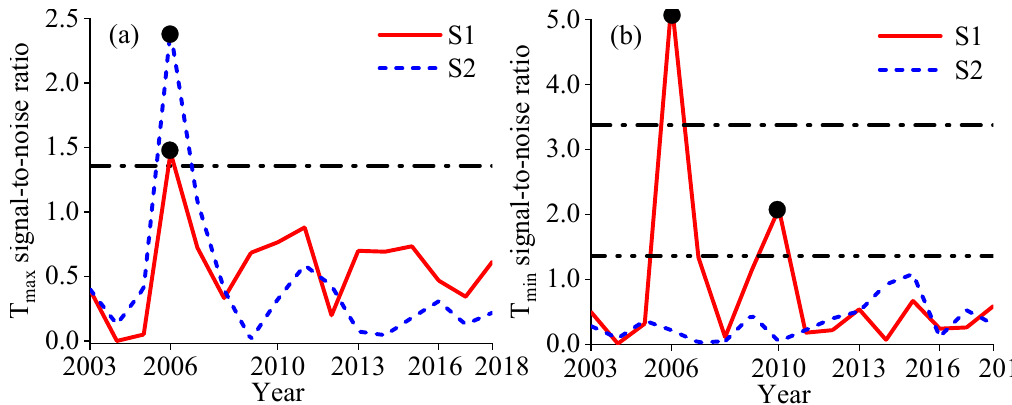
Figure 6. Abrupt change detection for ( a ): T max , ( b ): T min , Yamamoto test. S1 and S2 represent two regions of the study area.